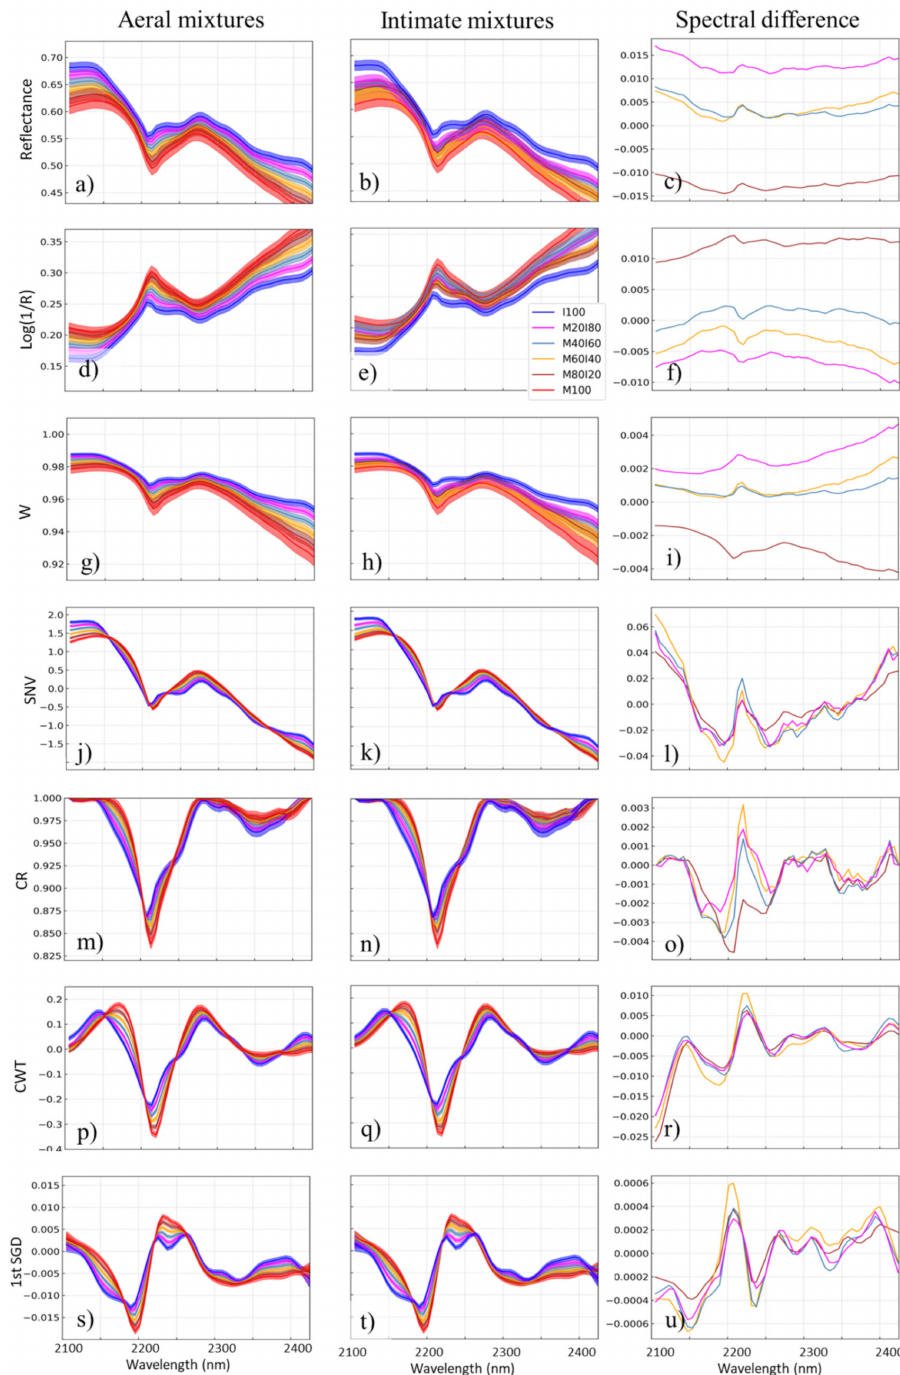
Figure 6. Montmorillonite–illite mixtures: from ( a ) to ( c ) reflectance spectra and from ( d ) to ( u ) application of the 6 spectral preprocessings for aeral mixtures (first column) and intimate mixture (second column), di ff erence between mean spectra of aeral and intimate mixtures (third column; line: mean reflectance, ribbon: mean ± one standard